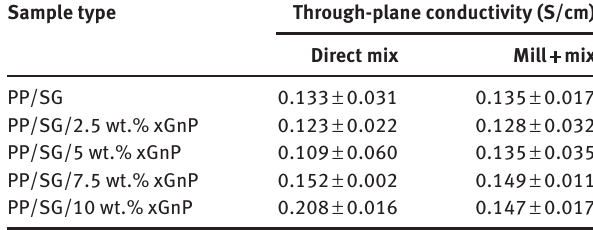
Table 3: The through-plane electrical conductivities of the PP